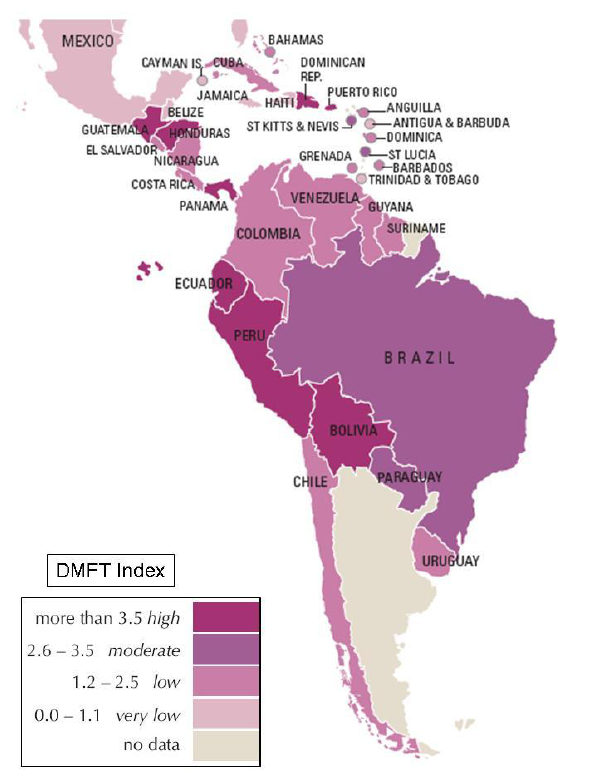
Figure 1: Dental caries in Latin America. The DMFT index. Average number of decayed (D), missing (M), and filled (F) teeth in 12-year-olds. Latest available data 1994-2014. Source: FDI World Dental Federation;